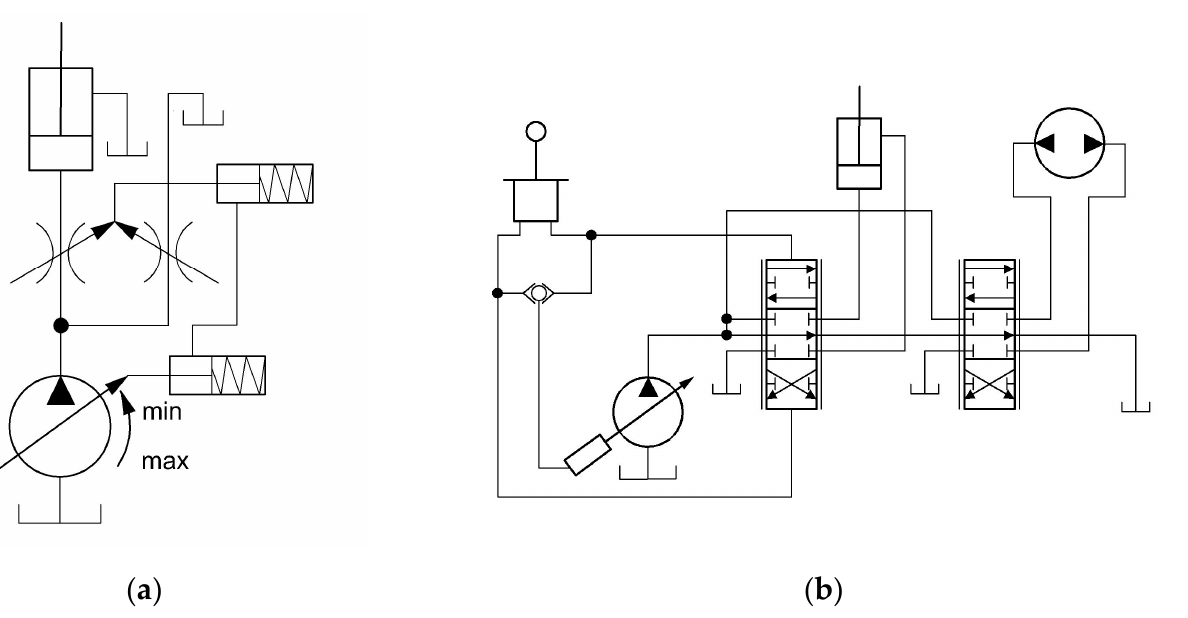
Figure 1. Positive flow-control system. ( a ) Structure diagram of positive flow-control system. ( b ) Schematic diagram of positive flow-control system.